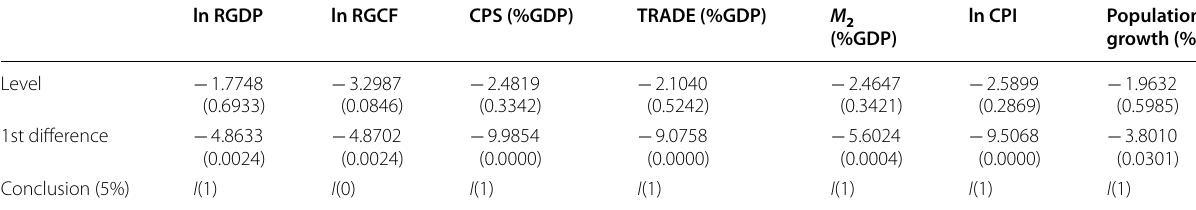
Figures in bracket are probability values